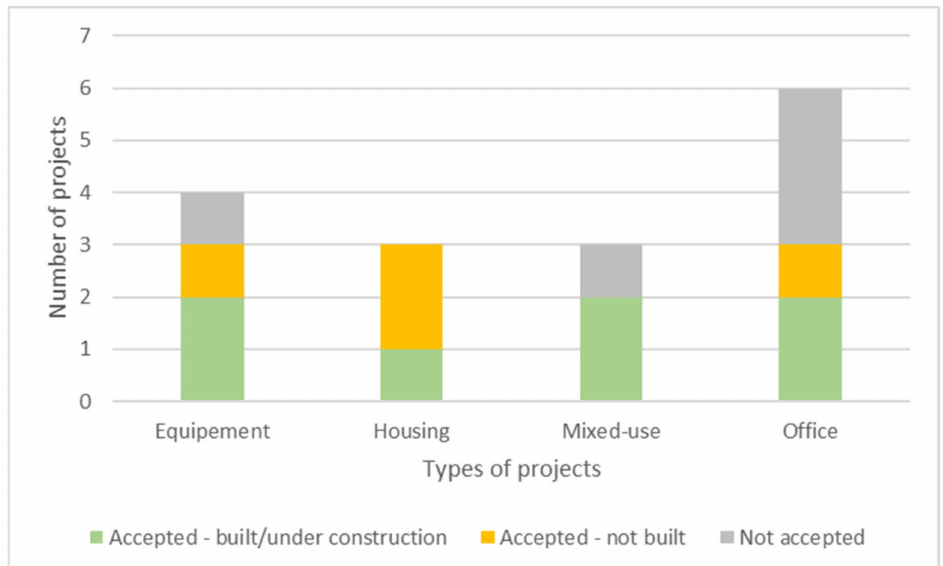
Figure 3. Distribution of projects status according to their types.